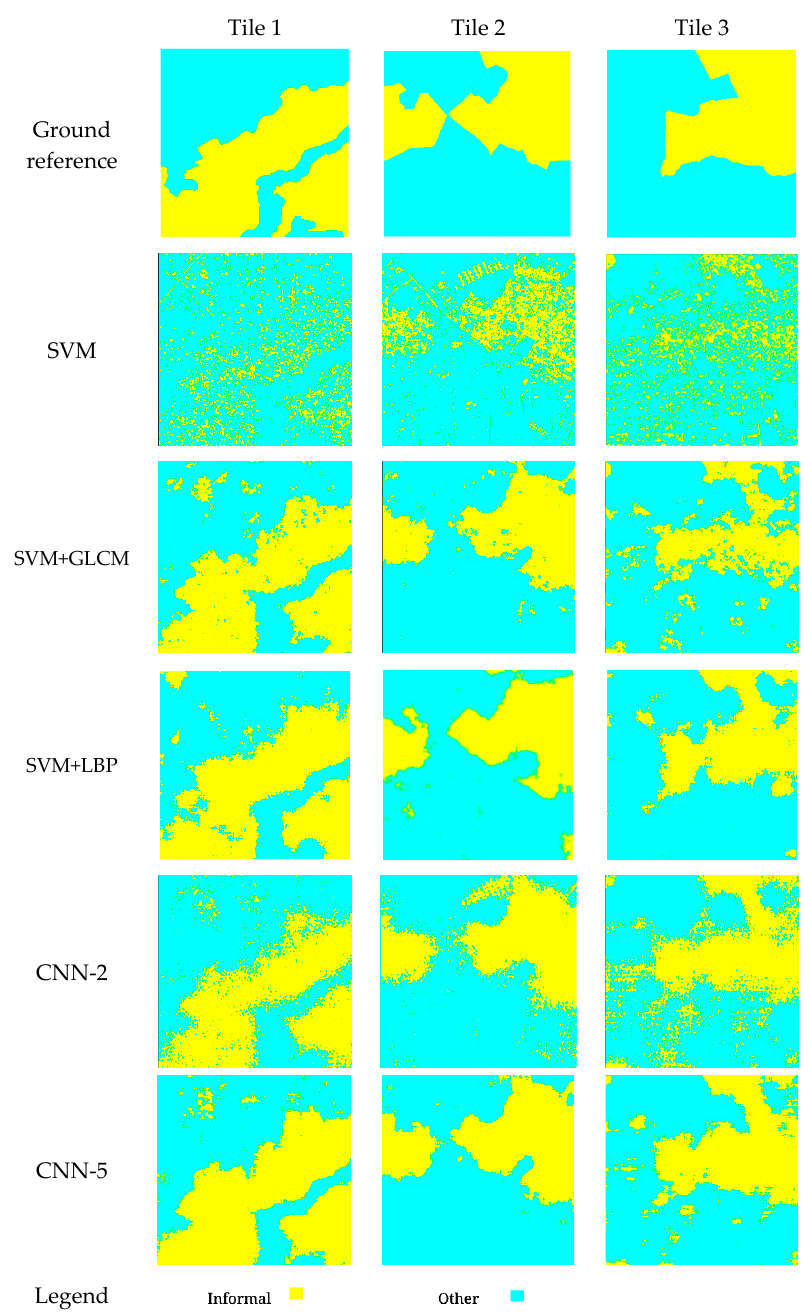
Figure 7. Classification maps from SVM, SVM relying on GLCM features, SVM relying on LBP features and CNN for Tile 1, Tile 2 and Tile 3.